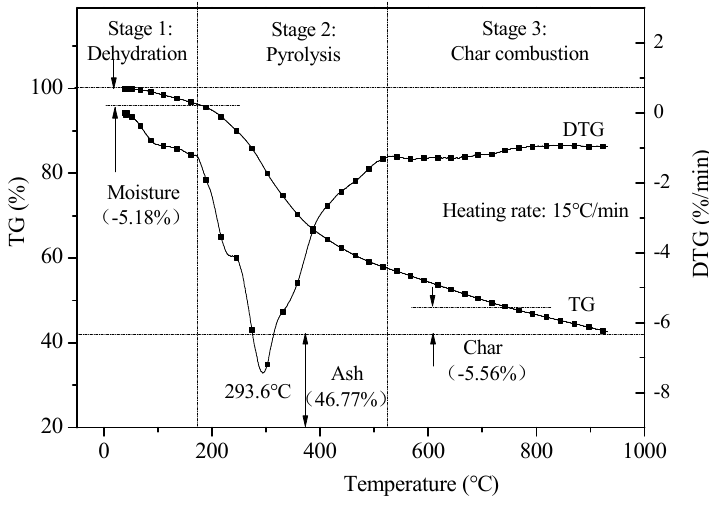
Figure 3. Thermogravimetric analysis of dry sewage sludge.